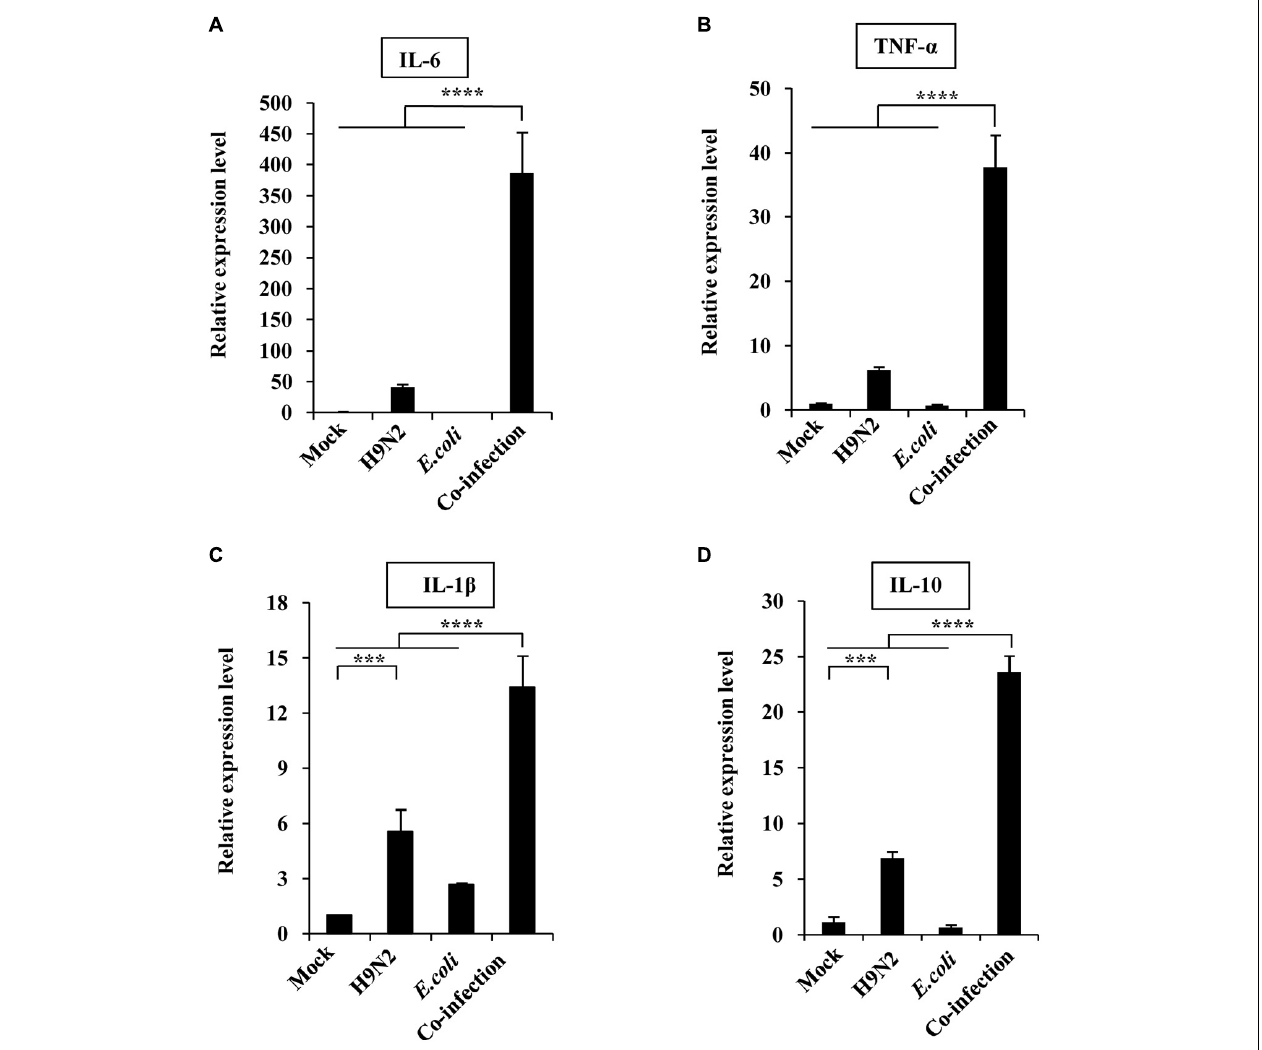
FIGURE 2 | Viral-bacterial co-infection induces excessive expression of inflammatory factors. Four groups of BALB/c mice were mock infected, or intranasally infected with single H9N2 AIV (1 × 10 4 PFU) and E. coli (1.5 × 10 7 CFU), or co-infected with H9N2 and E. coli for 48 h. Quantitative real-time PCR was used to measure the expression of IL-6 (A) , TNF- α (B) , IL-1 β (C) , and IL-10 (D) in mouse lungs. Data are presented as the mean ± SD of three independent experiments. *** P < 0.001, **** P <